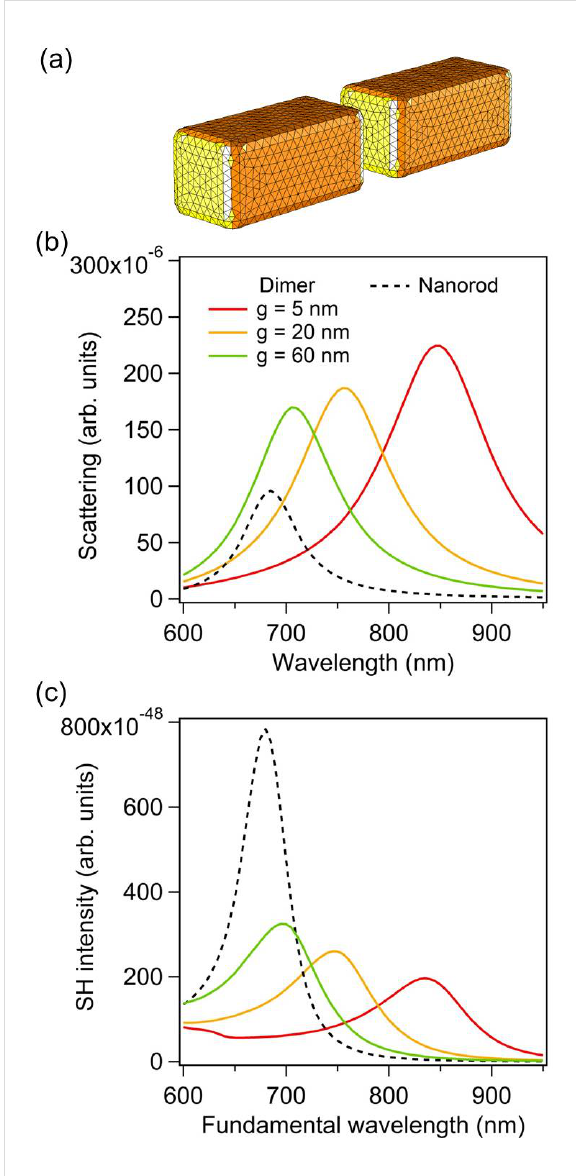
Figure 7: (a) Example of one mesh used for the simulations for the dimers with rectangular arms. The nanoparticle length is 85 nm and the height and width are 40 nm. In the present case, the gap g is 20 nm. (b) Scattering as a function of the wavelength for nanodimers with gaps g = 5 nm, 20 nm, and 60 nm as well as for a single nanopar- ticle. (c) Second harmonic intensity as a function of the wavelength for nanodimers with gaps g = 5 nm, 20 nm, and 60 nm as well as for a single